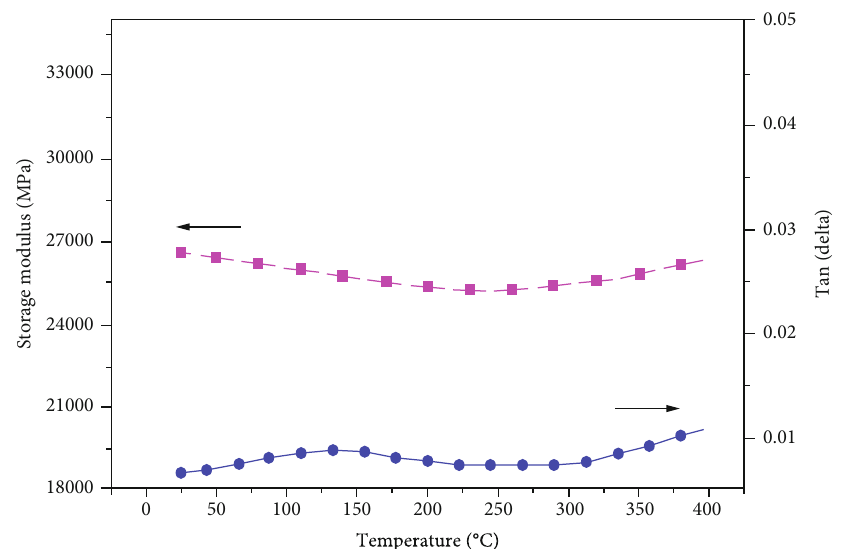
Figure 6: DMA curve of MDPES-2 composite.